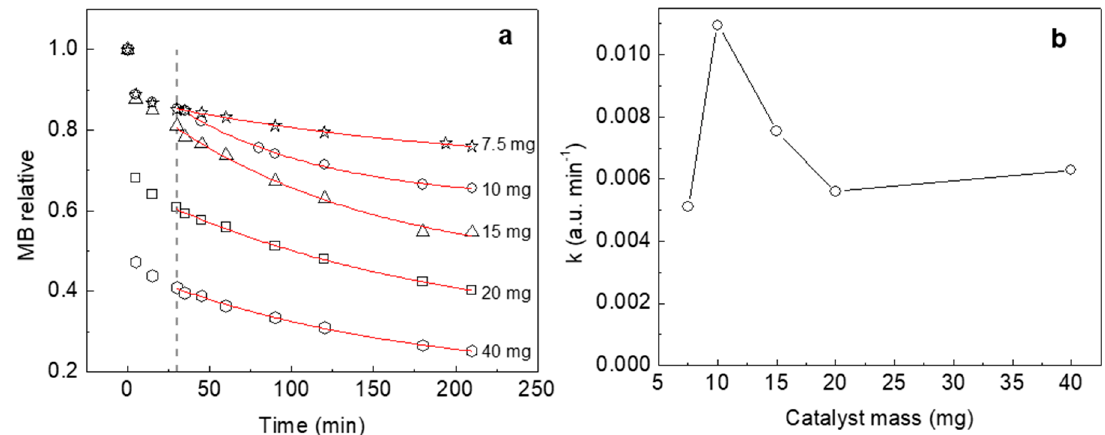
Figure 10. Photodegradation of MB by using a different amount of SnO2CLI25. ( a ) Temporal profile of MB concentration with different amounts of the catalyst and ( b ) values of rate constants versus the catalyst mass. The beginning of the illumination phase is marked by a dashed line. Reaction conditions: V = 50 cm 3 , O 2 flow = 25 cm 3 min − 1 , T = 22 °C, C 0 = 10 mg dm − 3 .To separate the adsorption